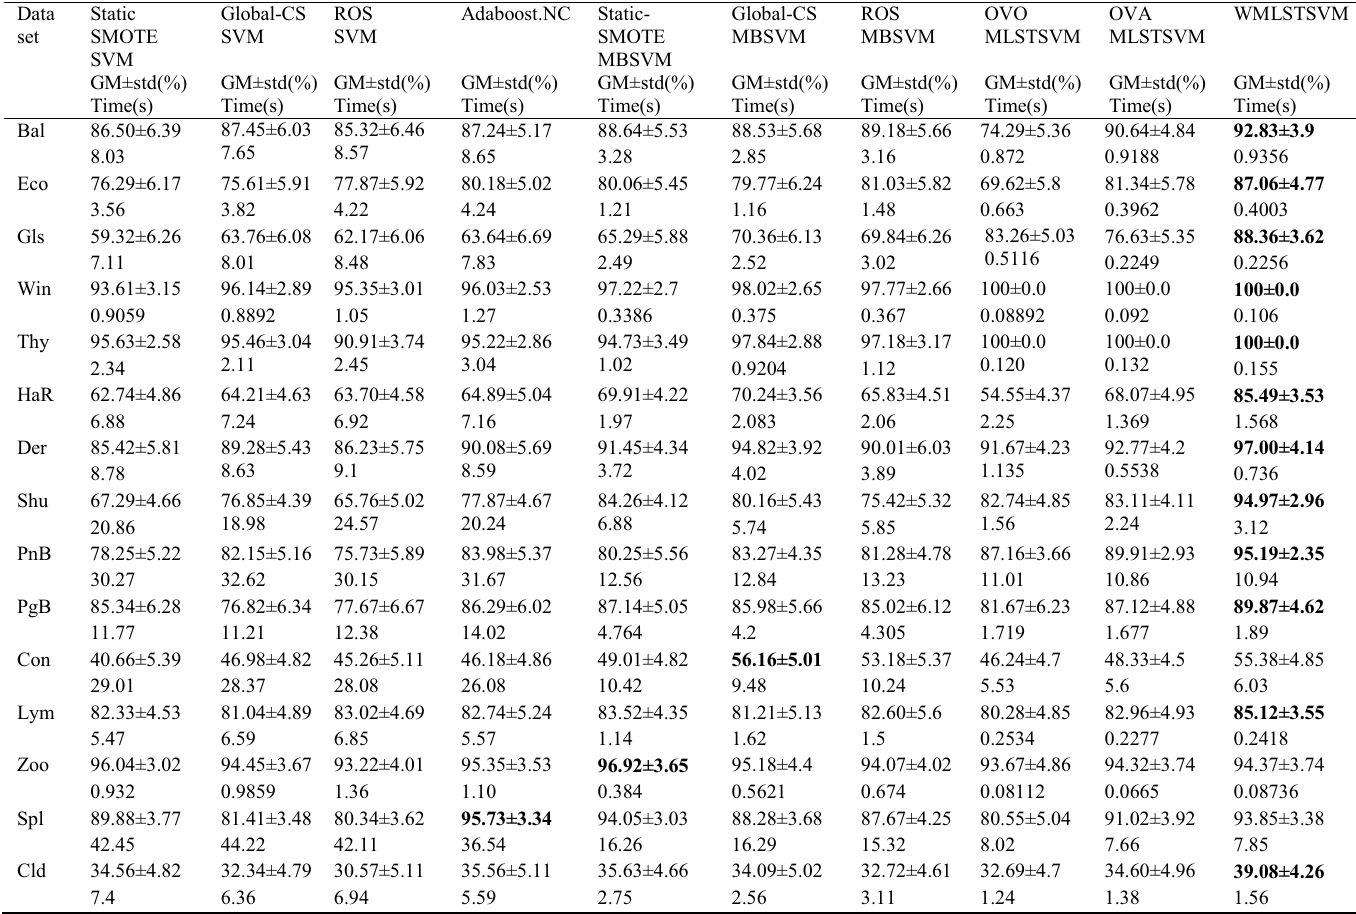
Table 4. Geometric Mean Comparison of non-linear classifiers on benchmark datasets